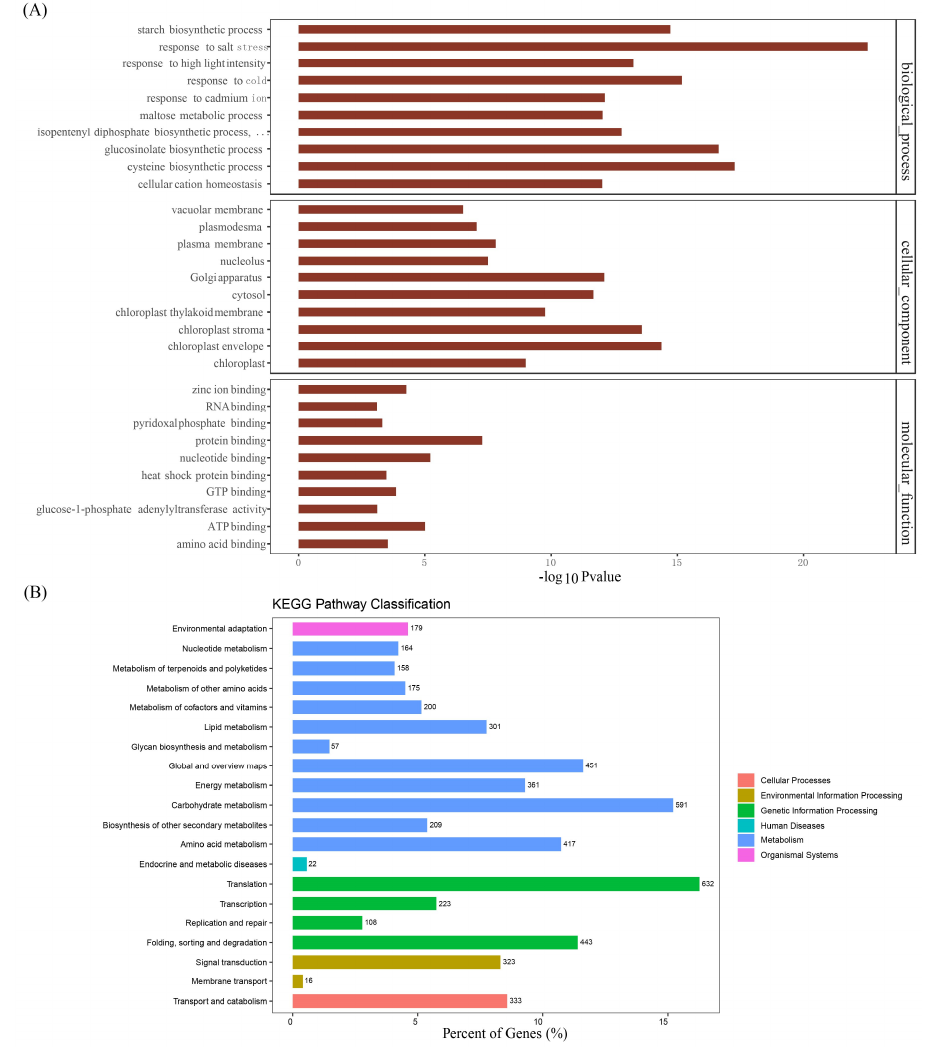
Figure 7. Di ff erential expression genes enrichment analysis. ( A ) Di ff erential expression genes GO enrichment; ( B ) di ff erential expression genes KEGG